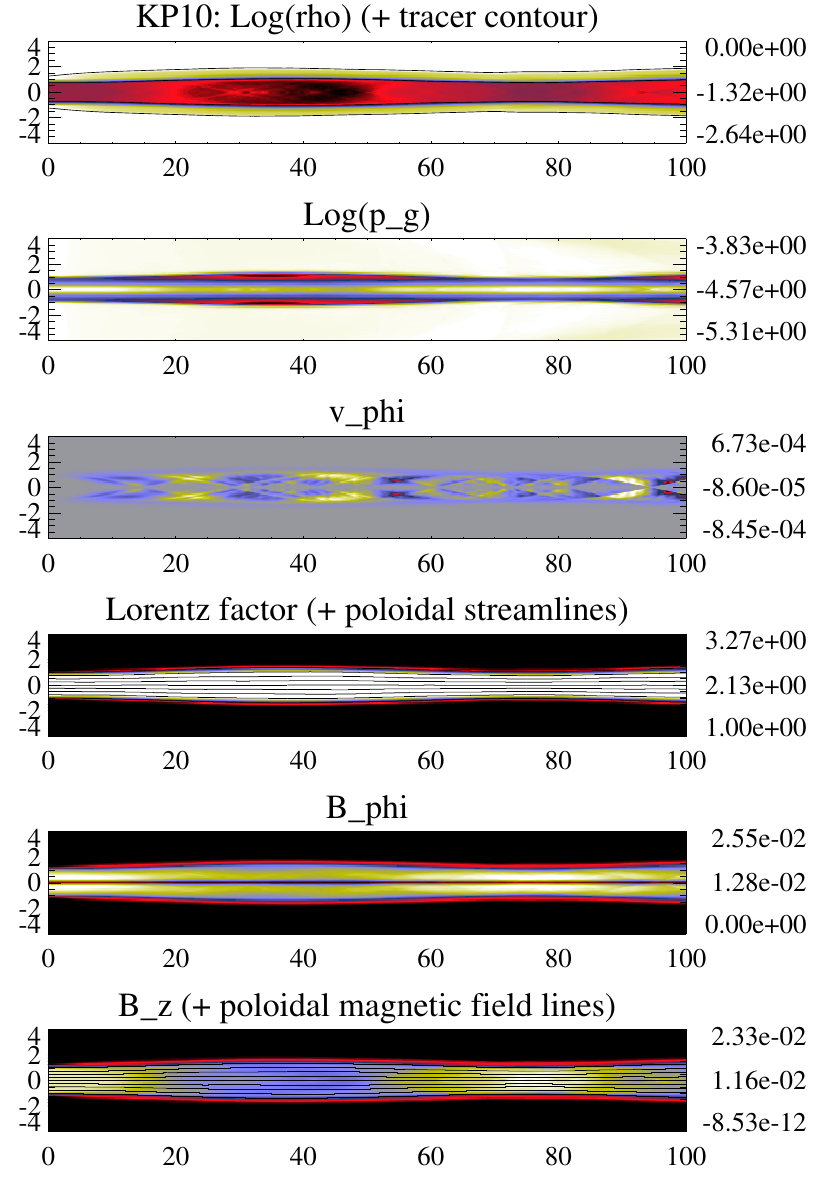
Figure 6. Steady structure of the kinetically-dominated, highly magnetized jet KP10. Panel distribution as in Figure 4. The axial scale has been compressed by a factor of two with respect to the radial